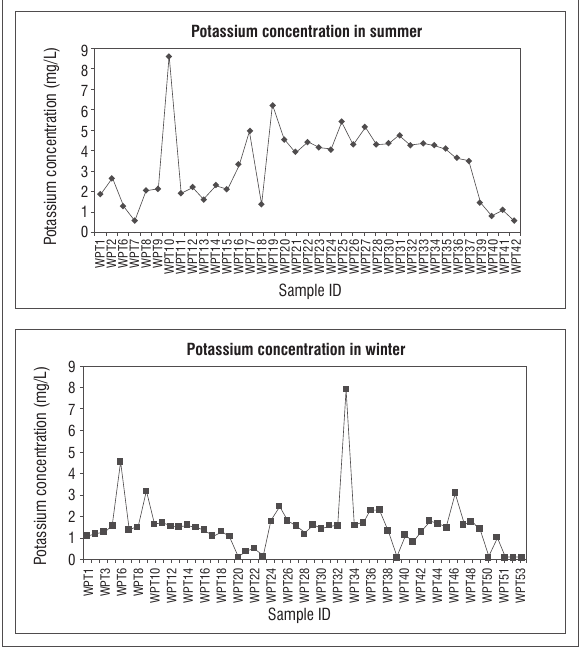
Figure 5: Seasonal variation of potassium concentration in Bonsma Dam. The iron concentration in the dam water ranged from 0.06 mg/L to 1.7 mg/L and thus exceeded the guidelines 17 for domestic (0–0.1 mg/L) and aquaculture (0.01 mg/L) use set by DWAF. The highest concentration was recorded in the wet season. The aluminium content of the dam, which ranged from 0.1 mg/L to 1.37 mg/L, did not meet the requirements for domestic (0–0.15 mg/L) or aquatic ecosystem (0–0.005 mg/L) uses. Distribution maps of the concentration of iron and aluminium are presented in Figure 6. The concentration of elements, pH and electrical conductivity measurements of water from Bonsma Dam are presented in Table